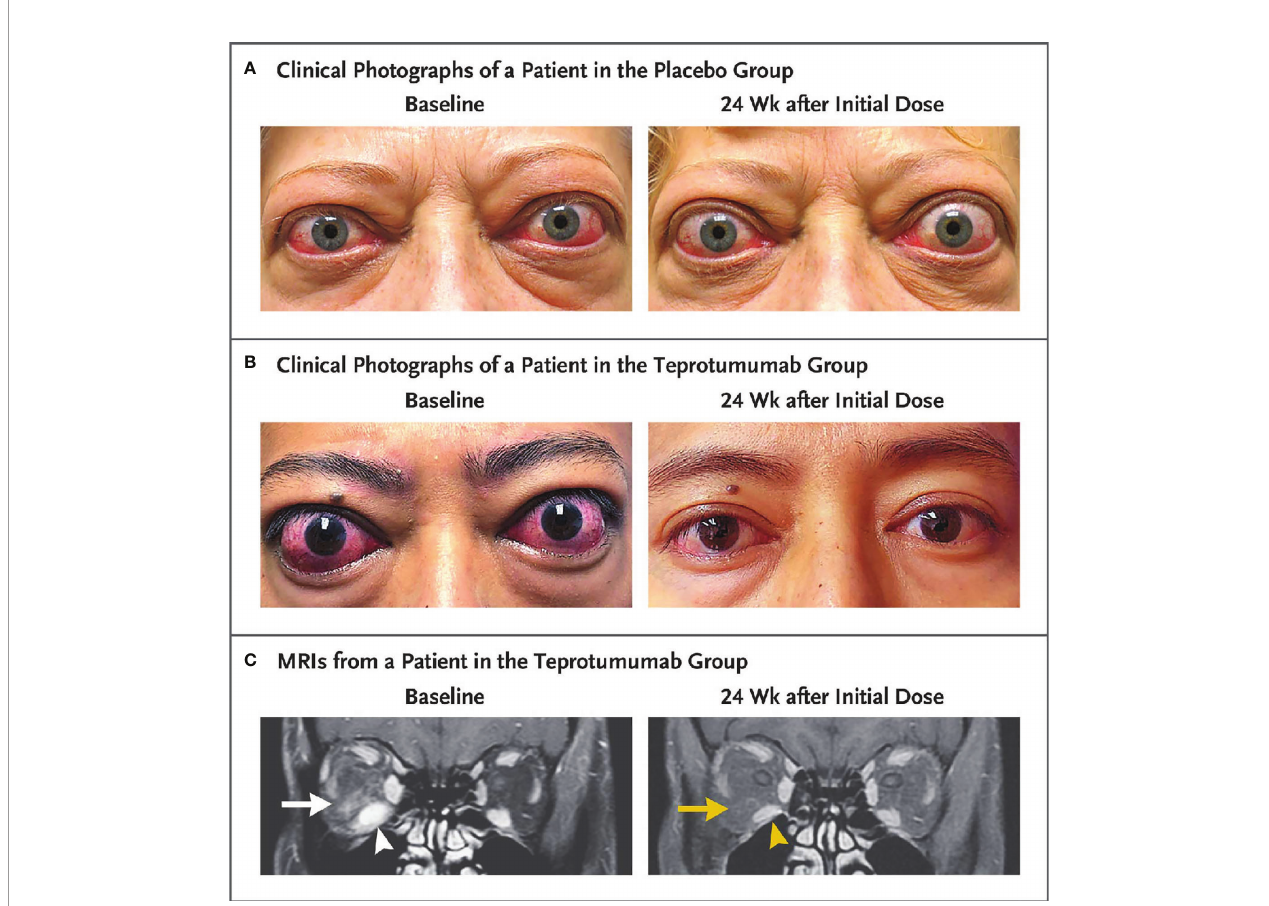
FIGURE 7 | Facial photographic images and MRIs at Baseline and 24 Weeks following treatment with either placebo or teprotumumab in patients enrolled in the Phase 3 trial. Panel (A) Clinical photographs of a patient receiving placebo. At baseline, the patient exhibits substantial proptosis (left eye, 29 mm and right eye, 27 mm) as well as multiple in fl ammatory signs (left eye Clinical Activity Score of 7 and right eye 5). At week 24, considerable proptosis and in fl ammatory signs remain. (B) Images of a teprotumumab-treated patient. Baseline proptosis (both eyes 24 mm), edema, upper and lower eyelid retraction, and multiple in fl ammatory signs (CAS 5 bilaterally). At week 24, considerable bilateral reductions in proptosis ( − 5 mm) and CAS ( − 4 points). (C) Coronal, contrast-enhanced, fat-saturated, T1- weighted MRIs in a single patient receiving teprotumumab at baseline and at week 24. Note marked enhancement of the inferior rectus muscle (white arrowhead) and orbital fat (white arrow) as well as inferior rectus muscle enlargement. At week 24, resolved inferior rectus muscle (yellow arrowhead) enhancement and orbital fat (yellow arrow). The muscle volume was reduced by 49% (yellow arrowhead). Proptosis reduction decreased from 23 mm at baseline to 18 mm at week 24. From